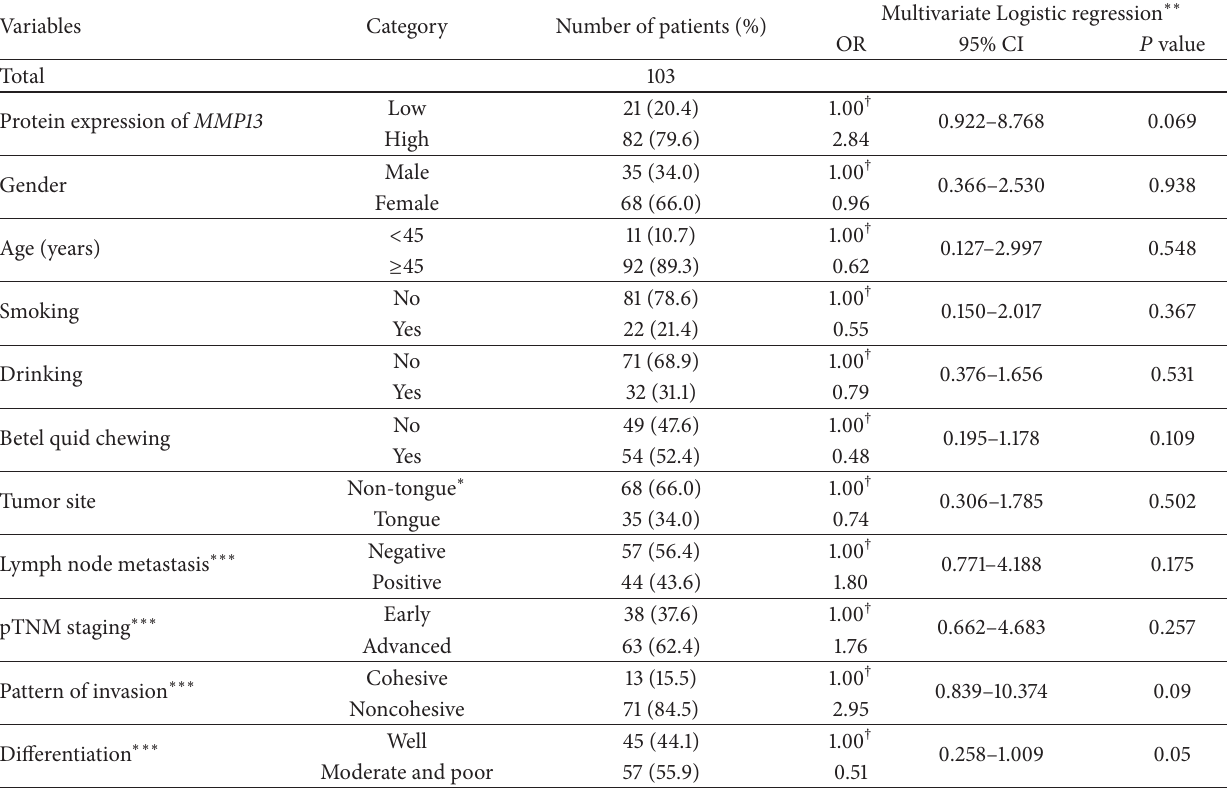
Table 4: Multivariate cox regression model analysis of MMP13 protein expression in OSCC overall